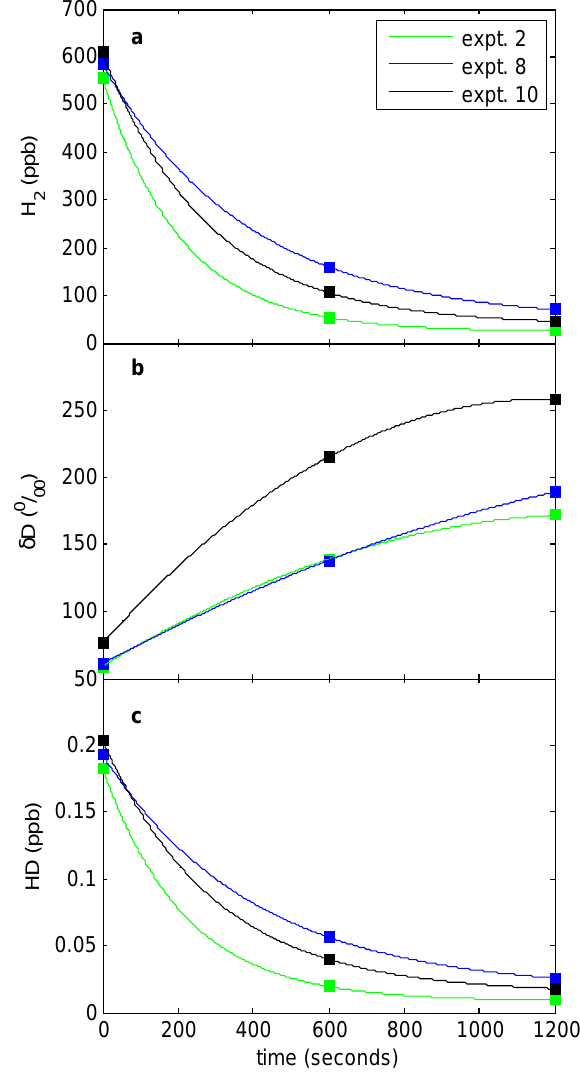
Fig. 1. Observed chamber concentrations of H 2 (a) , δ D (b) , and HD (c) during three representative experiments: experiment 2 (green squares), experiment 8 (blue squares), experiment 10 (black squares). Fits shown are based on Eqs. (2) and (4) for H 2 and HD from which decay constants were calculated. Measurement uncer- tainties are smaller than individual